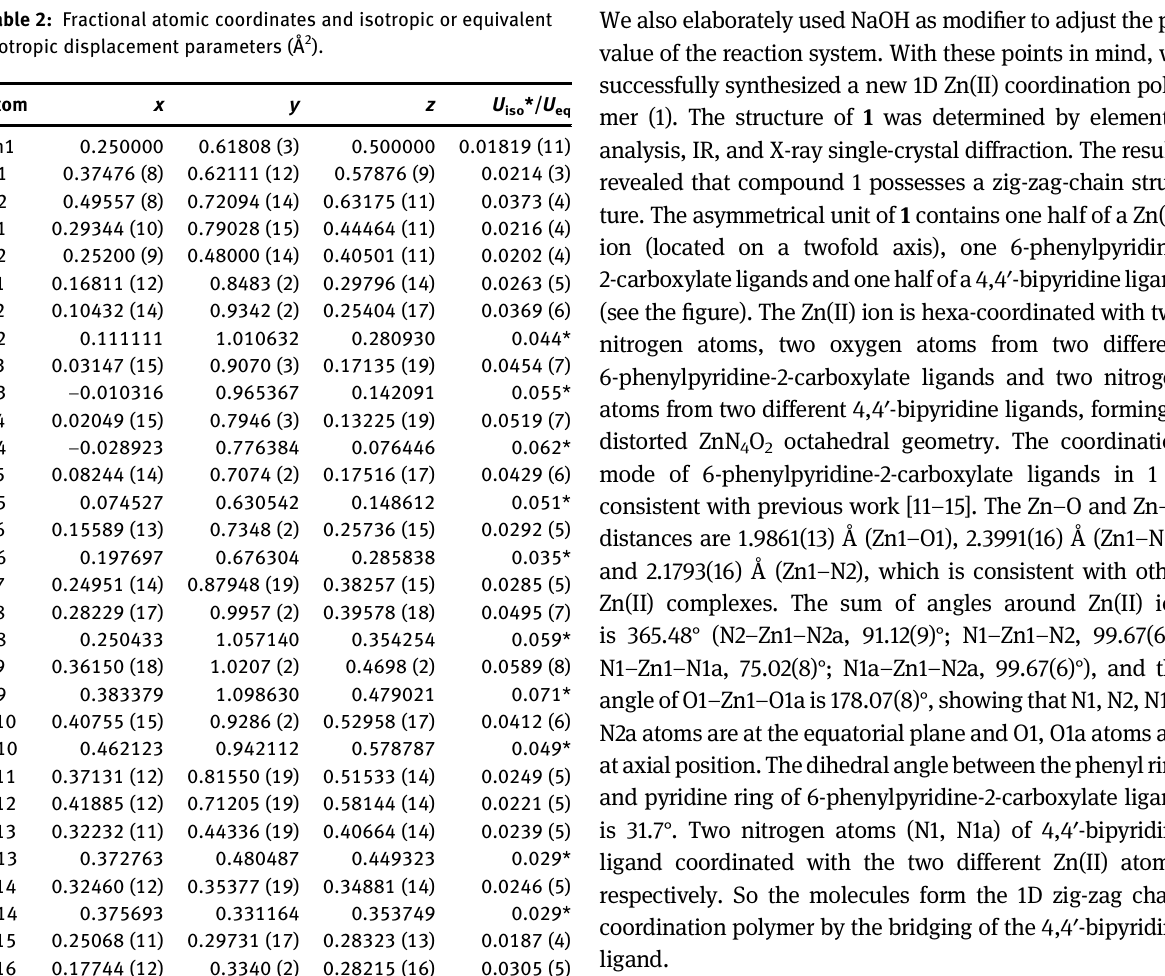
We also elaborately used NaOH as modi fi er to adjust the pH value of the reaction system. With these points in mind, we successfully synthesized a new 1D Zn(II) coordination poly- mer (1). The structure of 1 was determined by elemental analysis, IR, and X-ray single-crystal diffraction. The results revealed that compound 1 possesses a zig-zag-chain struc- ture. The asymmetrical unit of 1 contains one half of a Zn(II) ion (located on a twofold axis), one 6-phenylpyridine- 2-carboxylateligandsandonehalfofa4,4 ′ -bipyridineligand (see the fi gure). The Zn(II) ion is hexa-coordinated with two nitrogen atoms, two oxygen atoms from two different 6-phenylpyridine-2-carboxylate ligands and two nitrogen atoms from two different 4,4 ′ -bipyridine ligands, forming a distorted ZnN O octahedral geometry. The coordination 4 2 mode of 6-phenylpyridine-2-carboxylate ligands in 1 is consistent with previous work [11 – 15]. The Zn – O and Zn – N distances are 1.9861(13) Å (Zn1 – O1), 2.3991(16) Å (Zn1 – N1),